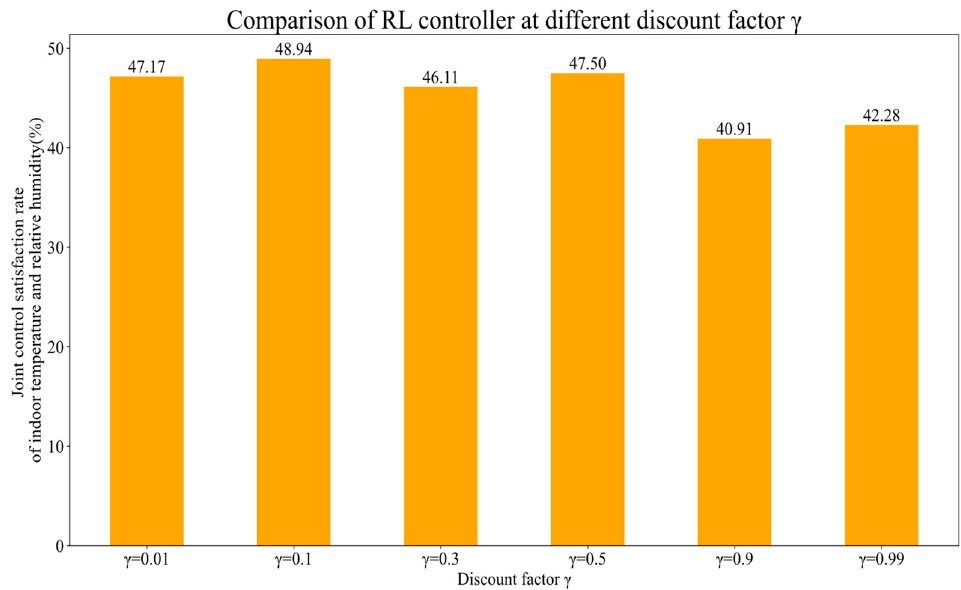
Figure 14. Comparison of RL controller at different discount factors.